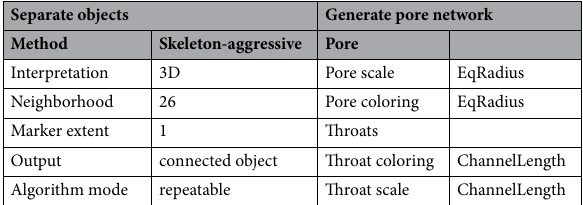
Table 4. On the basis of selecting the threshold value of pore structure model, the nylon pore network model was obtained after proper processing, as shown in Fig. 10. In this figure, the sphere represents the pore inside the nylon, and the cylinder represents the internal throat. The larger the sphere is, the larger the pore size is. Similarly, the thicker the cylinder is, the larger the throat radius is. The pore network model (i.e. the bat model) can directly reflect the connectivity characteristics of the pores in nylon sample. Depending on both the pore network model 20,21 and Avizo statistical method, the characteristic parameters of pore-fracture structure were quantitatively counted. The total number of pore reaches 15,849, and the number of throat yields 24,207. The specific microscopic parameters are shown in Table 5. In order to further classify the pore-fracture structure of nylon, quantitative statistical parameters of nylon structure are illustrated in Fig. 11. As can be seen from Fig. 11, the number of pores is the largest when the pore radius is in the range of 3.0–4.0 μm, accounting for 20.8% of the total. Pore volume can reflect the uniformity of the pores in nylon. The larger the pore radius is, the larger the pore volume is. Therefore, the majority of pore volumes are concentrated in the range of 100-200μm 3 , and the distribution is relatively uniform. Throat is the main channel for rubber flowing through nylon. The characteristic parameters such as throat radius and length directly affect the seepage pressure and flow rate, which is illustrated as Fig. 12. Most of the throat radius are in the range of 1-2 μm, accounting for 33.9% of the total. The 12.7% throat length of nylon remains in the range of 0–10 μm, responging to the largest number of throat surface area at 0–1 μm 2 .